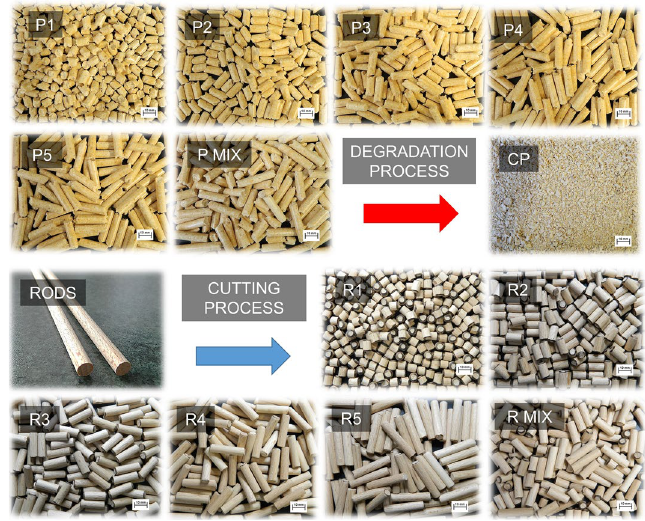
Figure 1. Particles used in